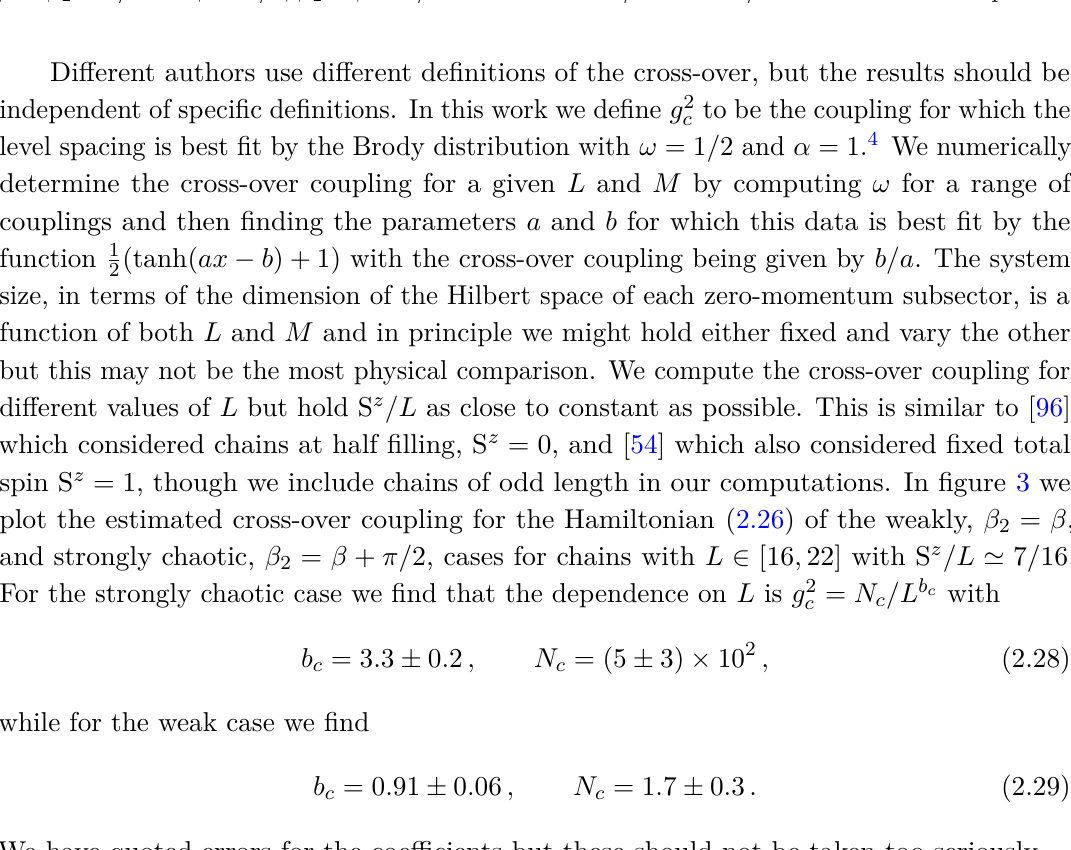
Figure 3 . Cross-over coupling for the twisted two-loop spin chain with L ∈ [16 , 22] for both β = β 2 = 1 / 5 and β = 1 / 5 , β 2 = β + π/ 2 . The curves ∼ 1 /L and ∼ 1 /L 3 are shown for